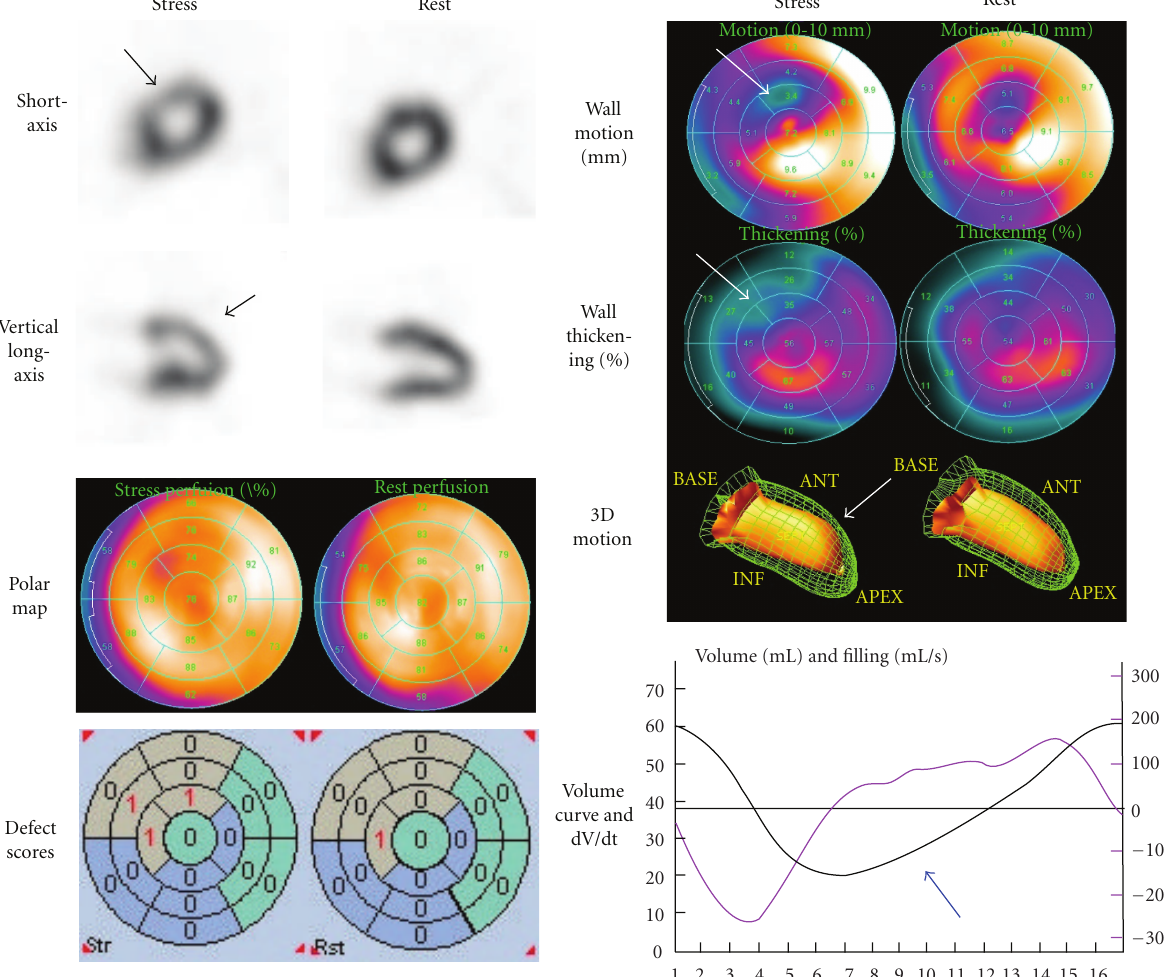
Figure 1: A patient with SSc showing slight anteroseptal ischemia. Quantitative analyses of perfusion, defect scores, wall motion and thickening showed significant abnormality, which supported abnormality in this region (arrows). Diastolic dysfunction was observed even at resting condition as shown by the blue